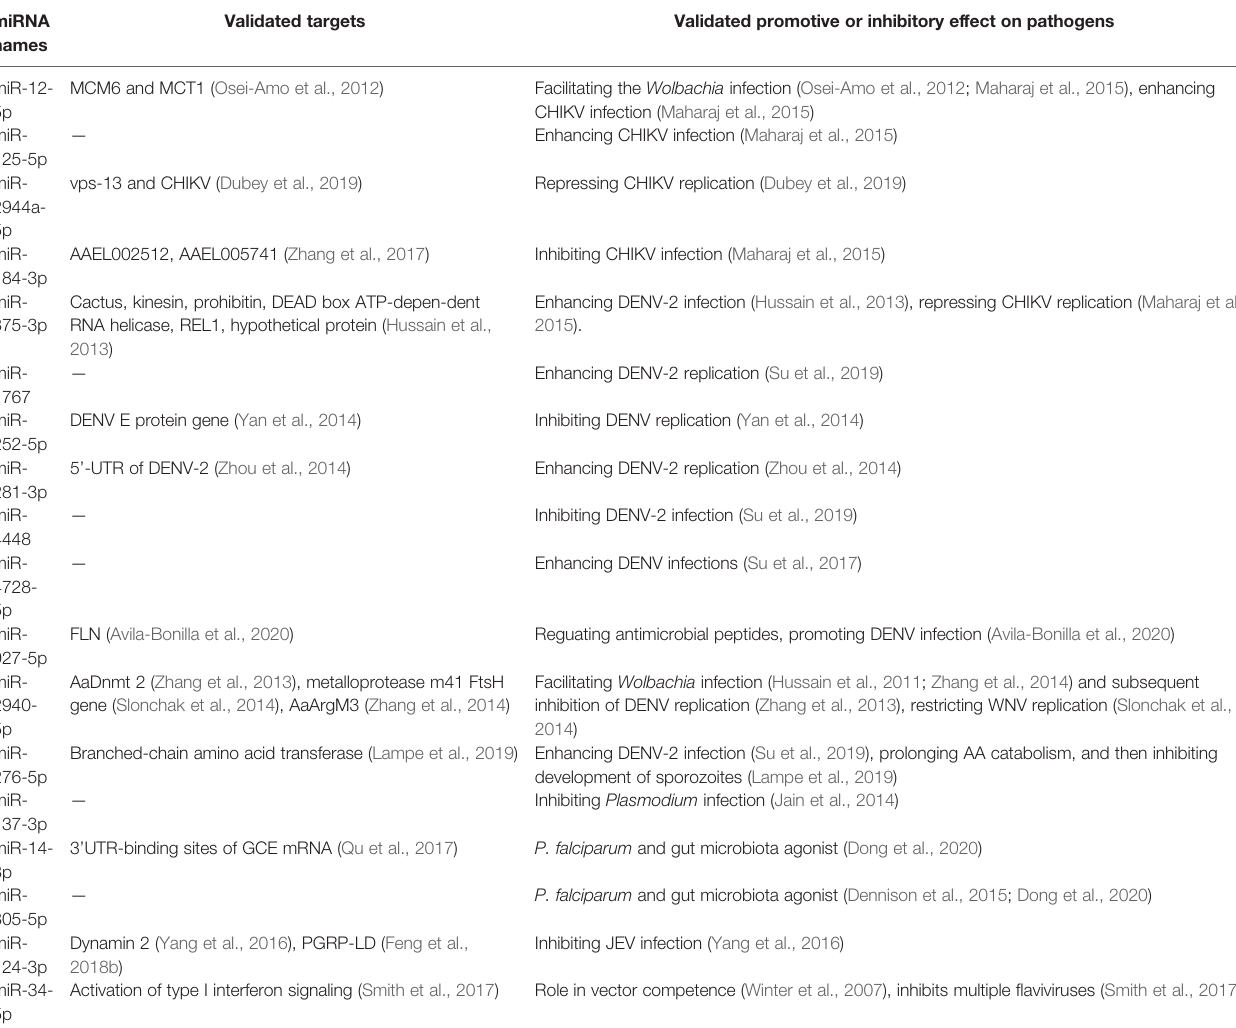
TABLE 7 | miRNAs with validated targets that exert promotive or inhibitory effects on pathogens. miRNA Validated names